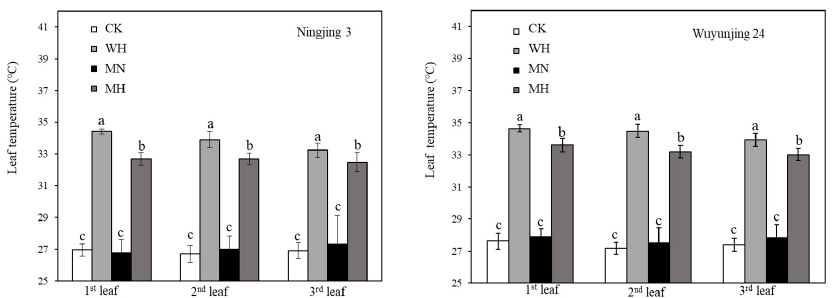
Figure 1. Leaf temperature of different treatments. Note: CK: natural temperature and sprayed with water; MN: natural temperature and sprayed with MeJA; WH: heat stress and sprayed with water; MH: high temperature and sprayed with MeJA. Bars are the standard deviation. Values followed by different letters are significantly different at the 5% probability level.